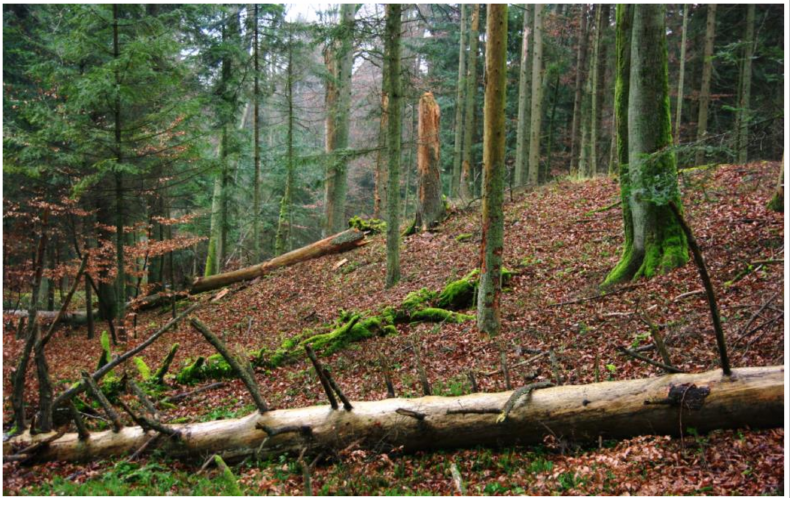
Figure 4. Deadwood in an upland mixed fir–beech forest (photo: S.